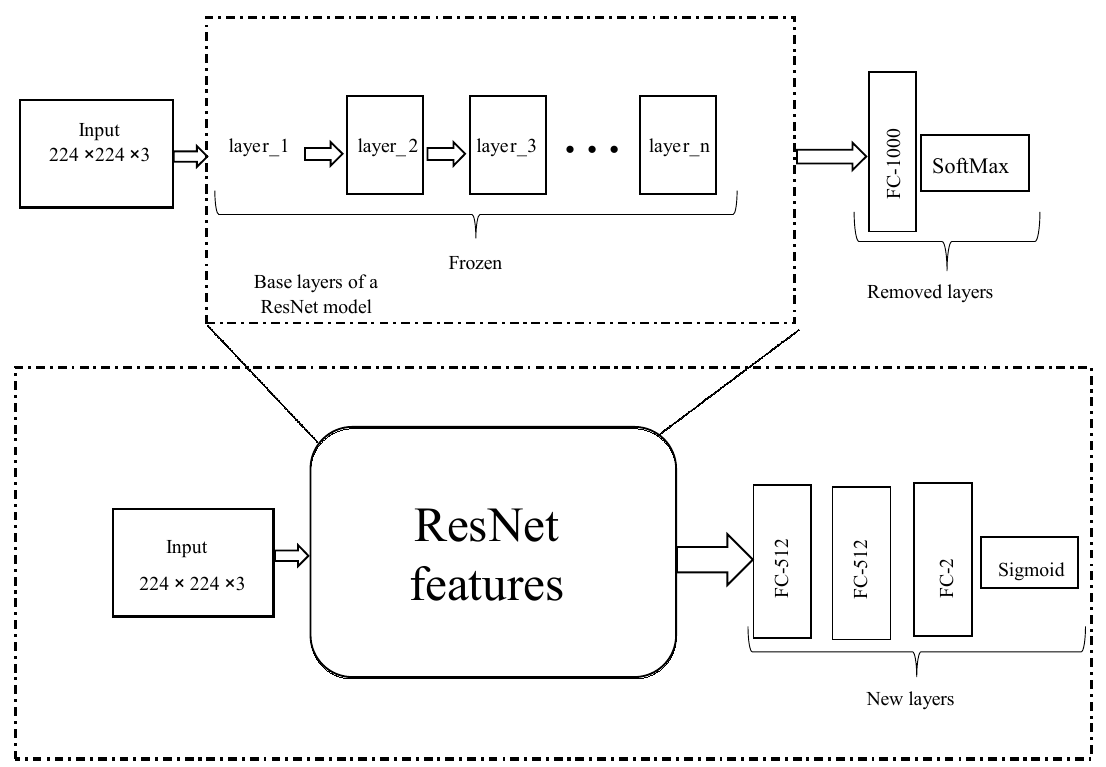
Figure 3. Illustration of fine-tuning .